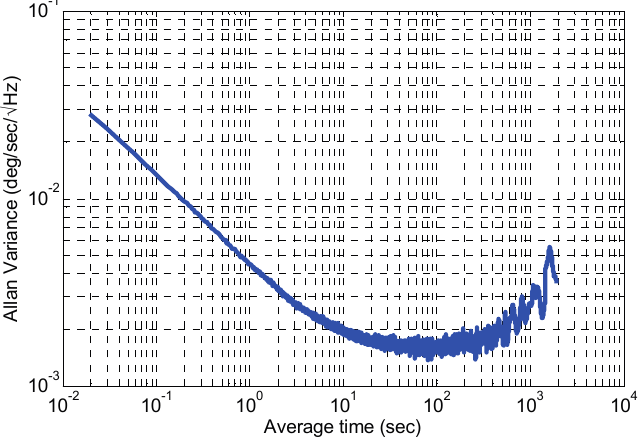
Figure 4. Allan variance of gyroscope signal third component.